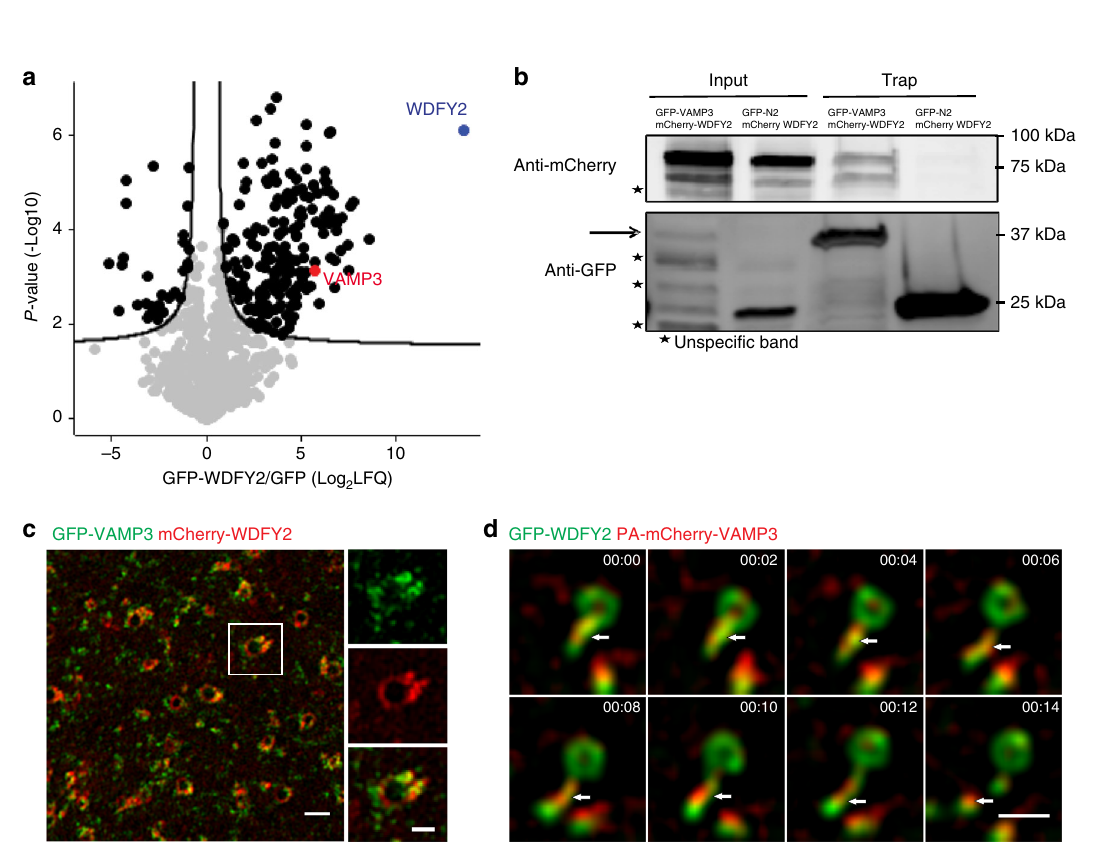
Fig. 4 WDFY2 interacts and colocalizes with VAMP3. a Volcano plot identifying enriched proteins isolated from cells expressing GFP-WDFY2 by GFP-trap af fi nity puri fi cation of cell lysates in comparison to GFP-expressing control cells. Label-free quanti fi cation (LFQ) ratios of GFP-WDFY2/GFP pulldowns were plotted against the p-value, with the permutation-based FDR threshold (<0.01) indicated by the black lines. b GFP af fi nity puri fi cation of GFP-VAMP3 and mCherry-WDFY2. Af fi nity isolation of GFP-VAMP3 coprecipitates mCherry-WDFY2, whereas isolation of GFP alone does not coprecipitate mCherry- WDFY2. One representative blot from three experiments is shown. c Representative SIM image showing GFP-VAMP3 and mCherry-WDFY2 localization to endosomes and endosomal tubules. Scale bar overview image: 1 µ m, scale bar of inset image: 0.5 µ m. Representative image from 13 observed cells. d Sequential images showing GFP-WDFY2 and PA-mCherry-VAMP3 localization to endosomes and endosomal tubule. The tubule pinches off and remains positive for VAMP3. Shown are frames from a time-lapse movie with images acquired every second. Representative image from 20 cells. Scale bar: 1 µ m. Source data are provided as a Source Data fi